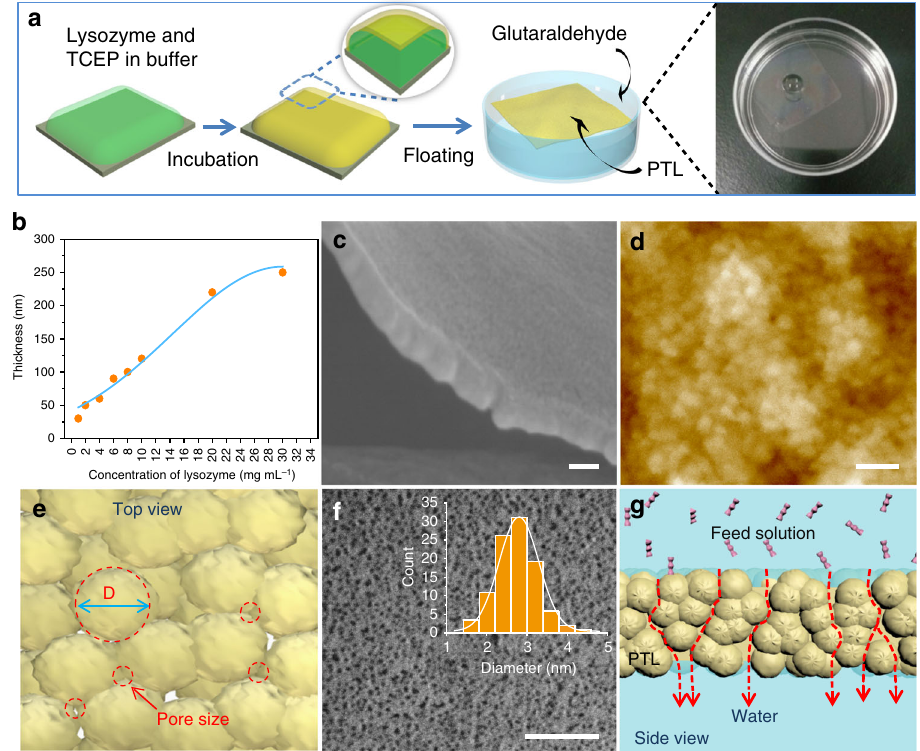
Fig. 1 The cross-linked PTL membrane and its pore structures. a Schematic of the preparation steps of the cross-linked PTL membranes. b The relationship between the membrane thickness and concentration of lysozyme. c SEM image of the cross-section of the membrane. d AFM image of the membrane. e Top view of the membrane showing the pores resulting from the packing of oligomer particles. The pore diameter ( d ) and particle size ( D ) have a relationship of d = D (2 − √ 3)/ √ 3 = 0.1547D. f Freeze-fracture TEM image of the membrane and its pore size distribution. g Side view of the membrane showing oligomer-surrounded tortuous channels for molecular transport. Scale bars in c , d , f are 50